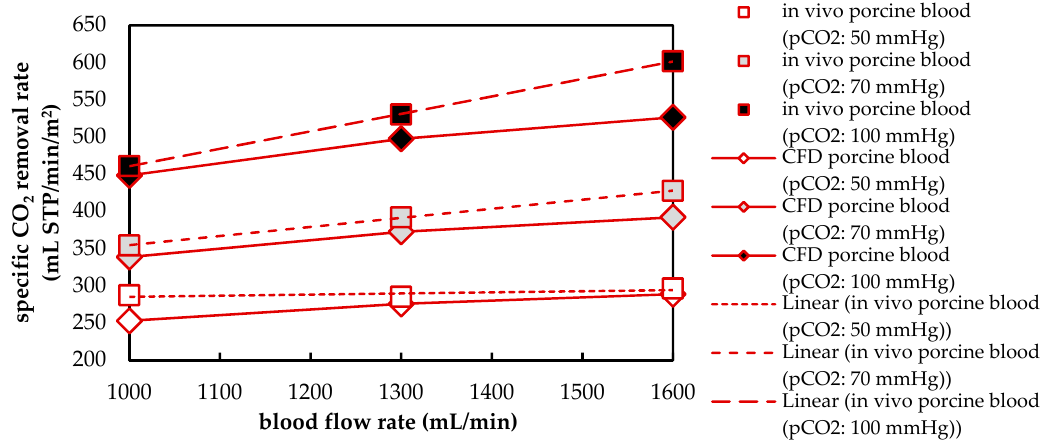
Figure 10. Comparison of CO 2 removal determined with experiments and CFD simulations for blood.